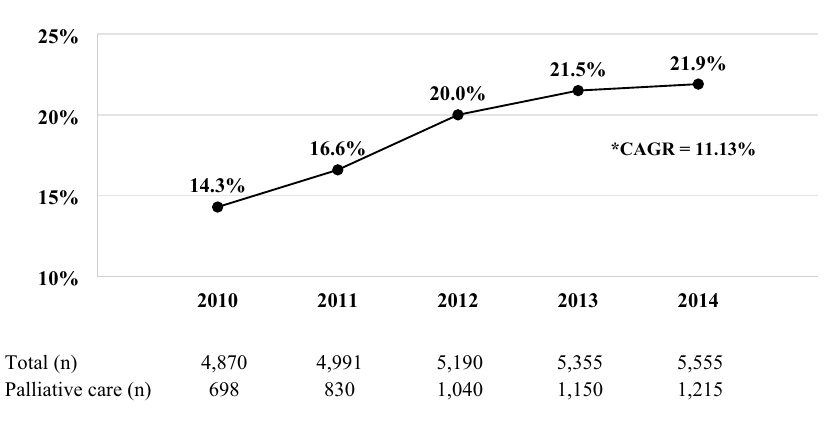
Figure 2. Trend in percentage of receiving palliative care between 2010 and 2014. *CAGR—Compound Annual Growth